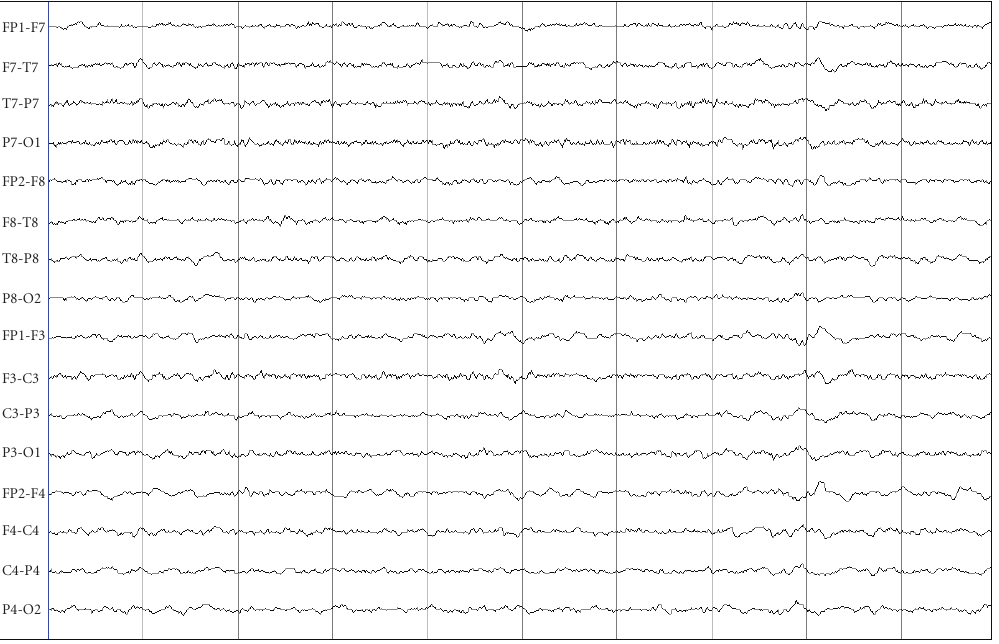
Figure 2: EEG after valproate therapy showing improvement of cerebral